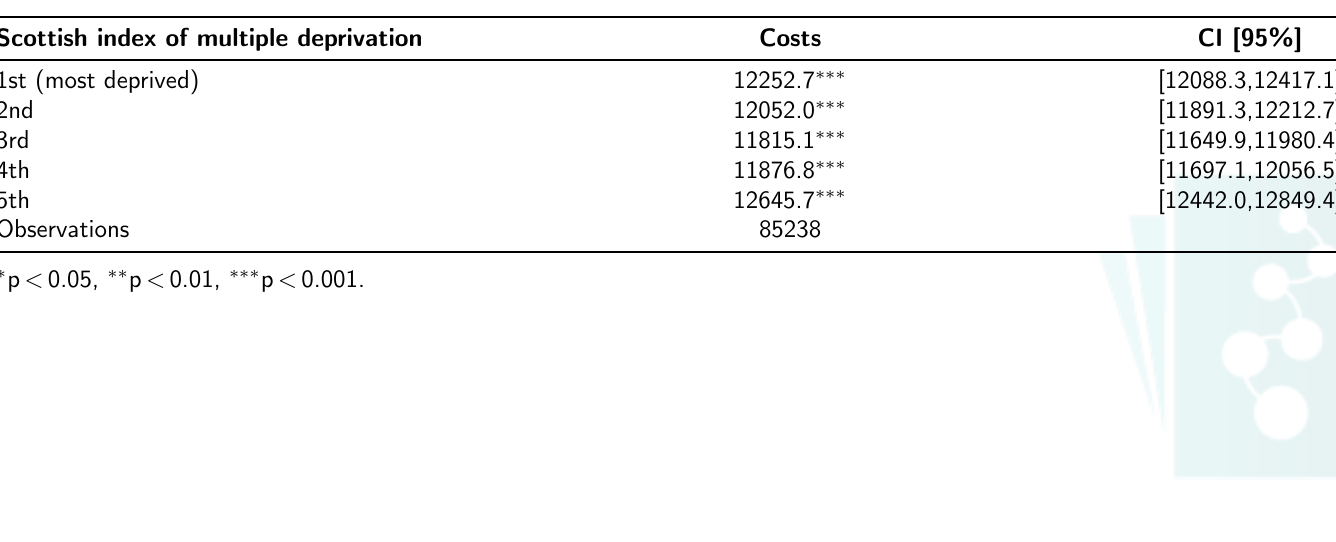
Supplementary Table 7: Univariate analysis GLM -